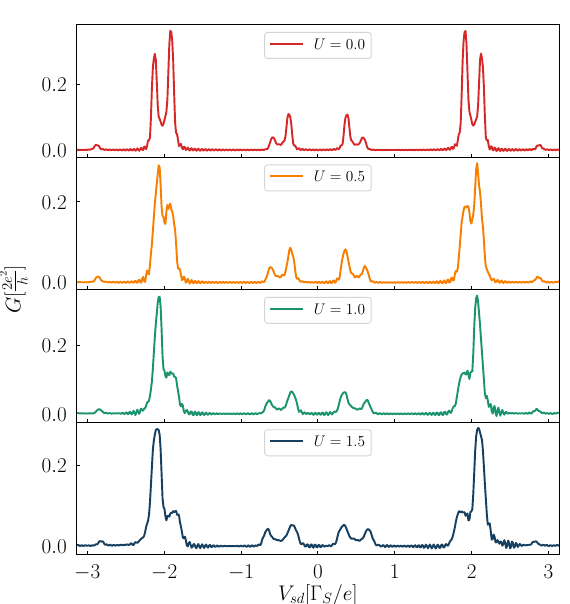
2 / h versus the source-drain